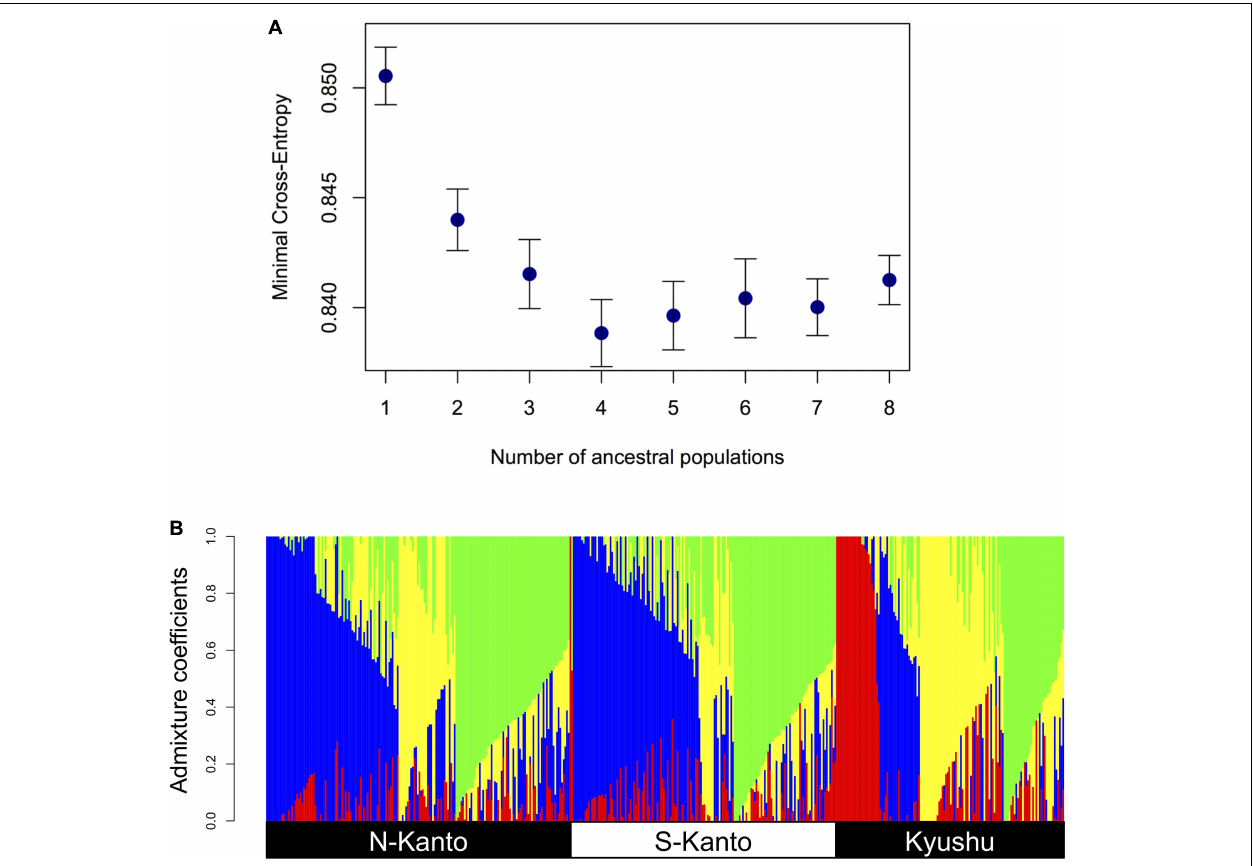
FIGURE 3 | (A) Relationship between minimal cross-entropy and number of ancestral populations ( K ) used in ancestry analysis. The values represent the averages of 10 replications. Error bars represent SE. (B) Bar-plot of admixture coefficients based on ancestry analysis using the 6,455 mapped SNPs at K = 4. Different colors represent different